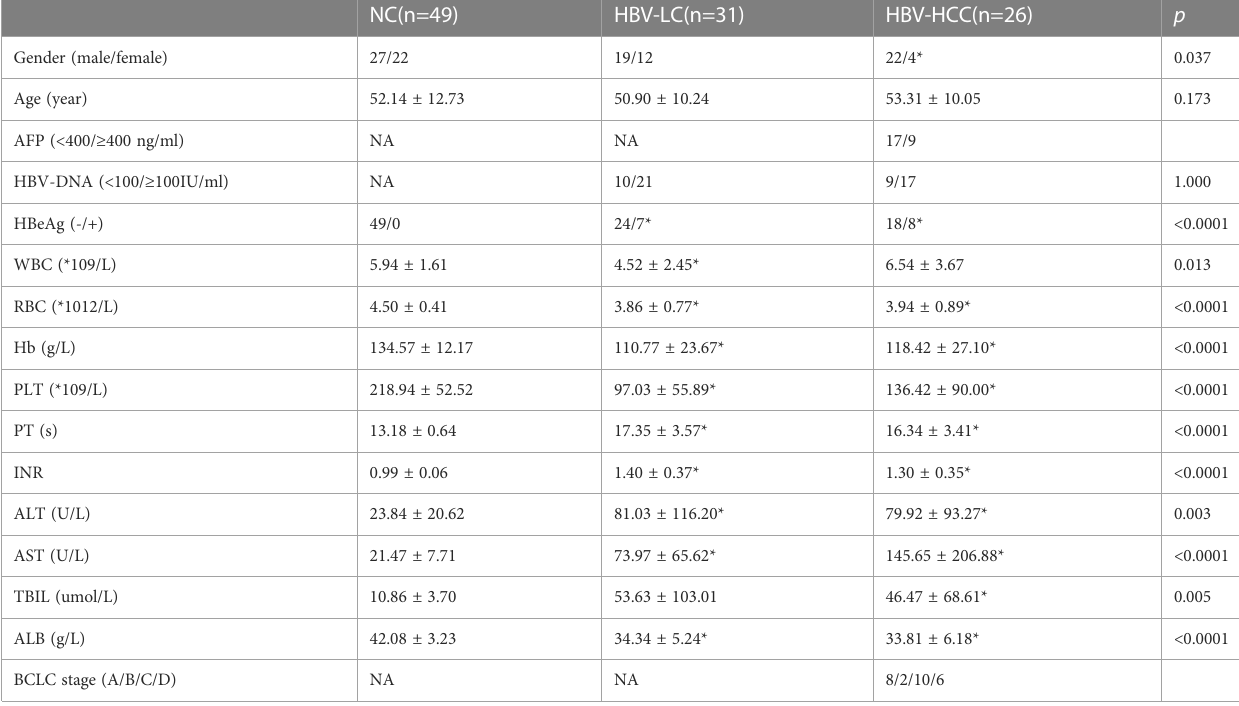
TABLE 1 Clinical characteristics of enrolled